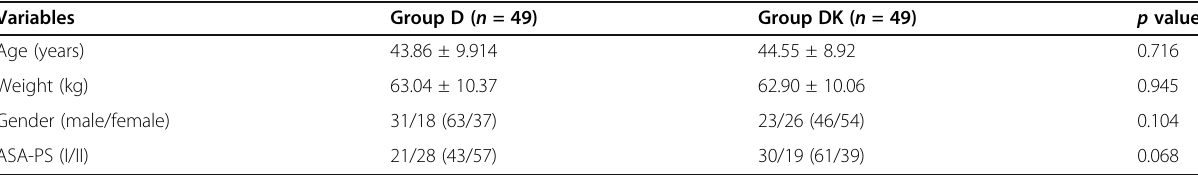
Table 1 Comparison of demographic data Variables